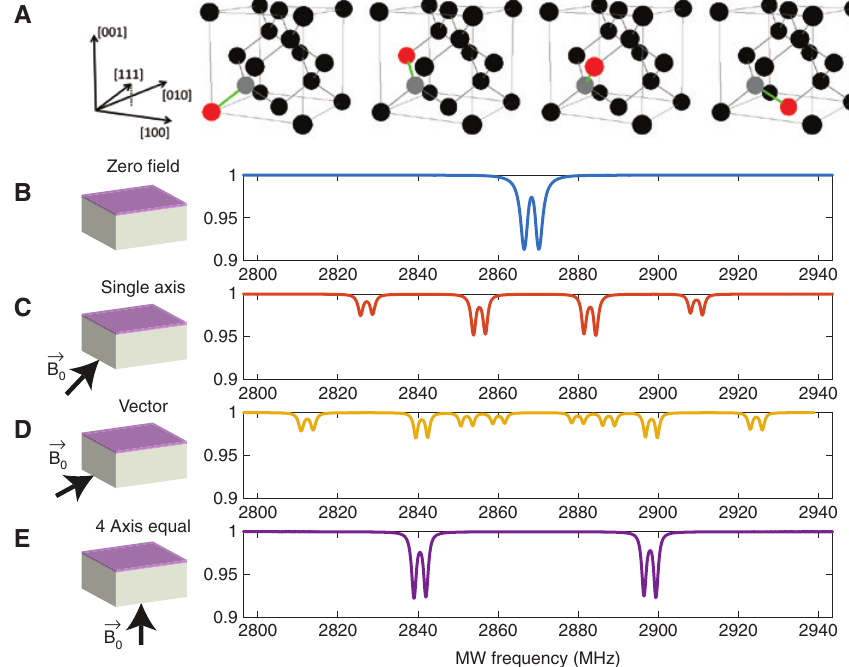
Figure 14: Experimental ODMR spectra for different bias magnetic field magnitudes and orientations. (A) Example of four possible NV orientations in the diamond lattice, and the crystallographic directions. (B) Example ensemble NV ODMR spectrum with | B | = 0. The resonance is centered at ∼ 2.87 GHz, but splits into two peaks around this resonance frequency because of the 15 N 0 hyperfine coupling. Strain and electric field also contribute to the ODMR lineshape and broadening, and can cause a variety of lineshapes at | B | = 0 for different samples. (C) Ensemble NV ODMR spectrum with | B | pointing along one axis. The frequency separation between the 0 0 outer resonance peaks is proportional to the applied field. The inner peaks are from the three other NV orientations overlapping with each other due to equal Zeeman interactions for each. The 15 N hyperfine interaction again splits each resonance into a doublet. (D) Ensemble NV ODMR spectrum with | B | orientation such that each axis has a different projection of bias field. (E) Ensemble NV ODMR spectrum with | B 0 along the [ 001 ] direction, such that each NV orientation has the same Zeeman interaction. The peak separation is proportional to the | B field projection along the NV